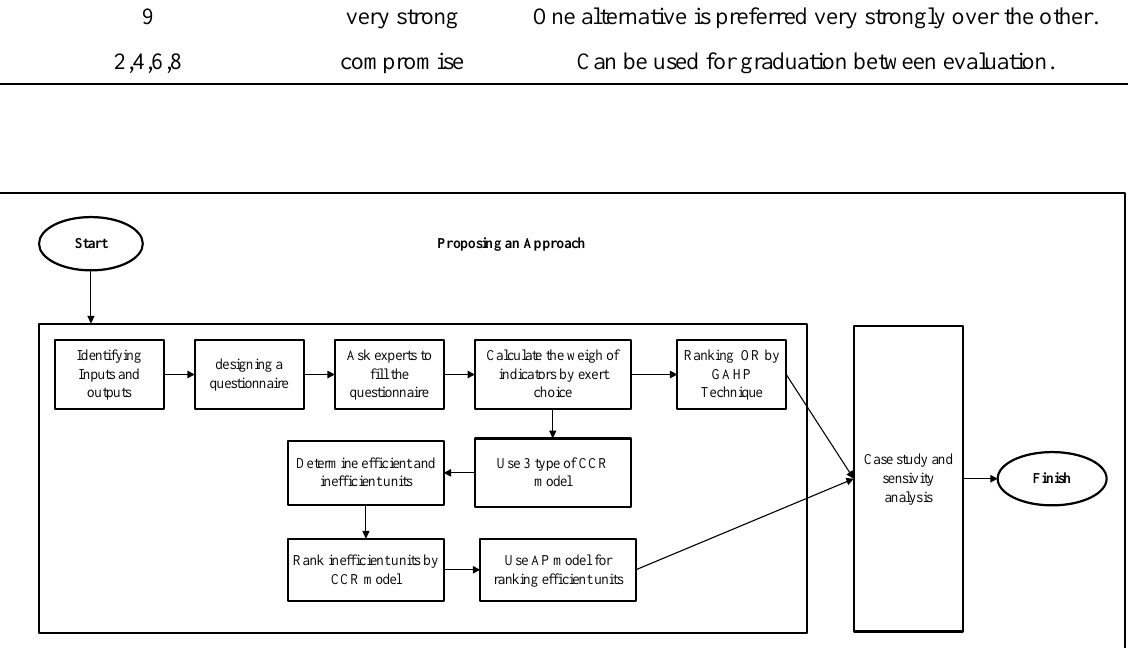
Figure 1. Diagram of proposed ranking OR.